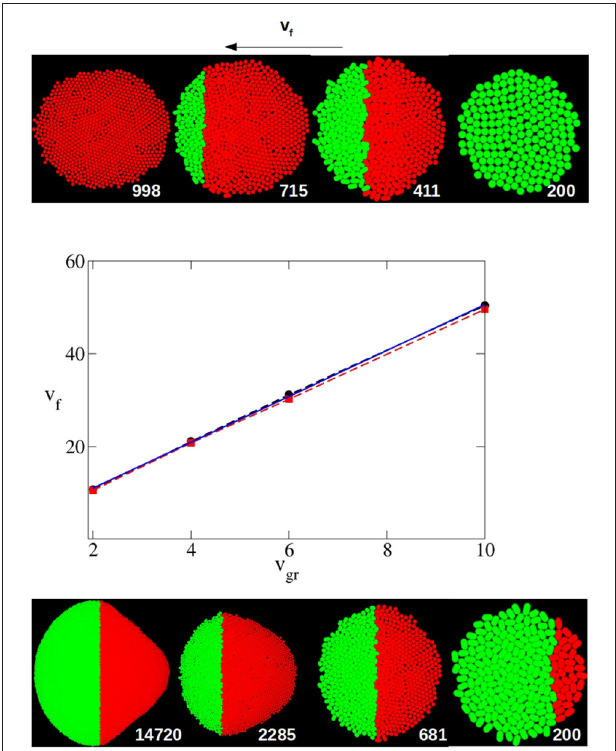
FIGURE 3 | Middle panel: Dependence of the highest and lowest value of v f for which eye growth termination does not occur ( v nc f , red square and dashed line) or does take place ( v c f , black circles and dashed line) with v gr as obtained by computer simulation for a circular primordium. The solid blue line is the limiting theoretical value of v f , v f , l , from Equation (16). Both v f and v gr are expressed in units of σ/τ . Top and bottom panel: From right to left, sequence in the evolution of the eye as obtained with the simulation algorithm. In the top panel an eye that terminates its growth ( v gr = 6 σ/τ , v f = 37 σ/τ , X 0 = 14.7 σ and ˜ F = 0.606). In the bottom panel the development of an eye that does not terminate growth ( v gr = 6 σ/τ , v f = 25 σ/τ , X 0 = 14.7 σ and ˜ F = 0.409). In both panels, the number of particles (cells) is printed close to each snapshot. Both cases start with the same circular primordium (top right snapshot).